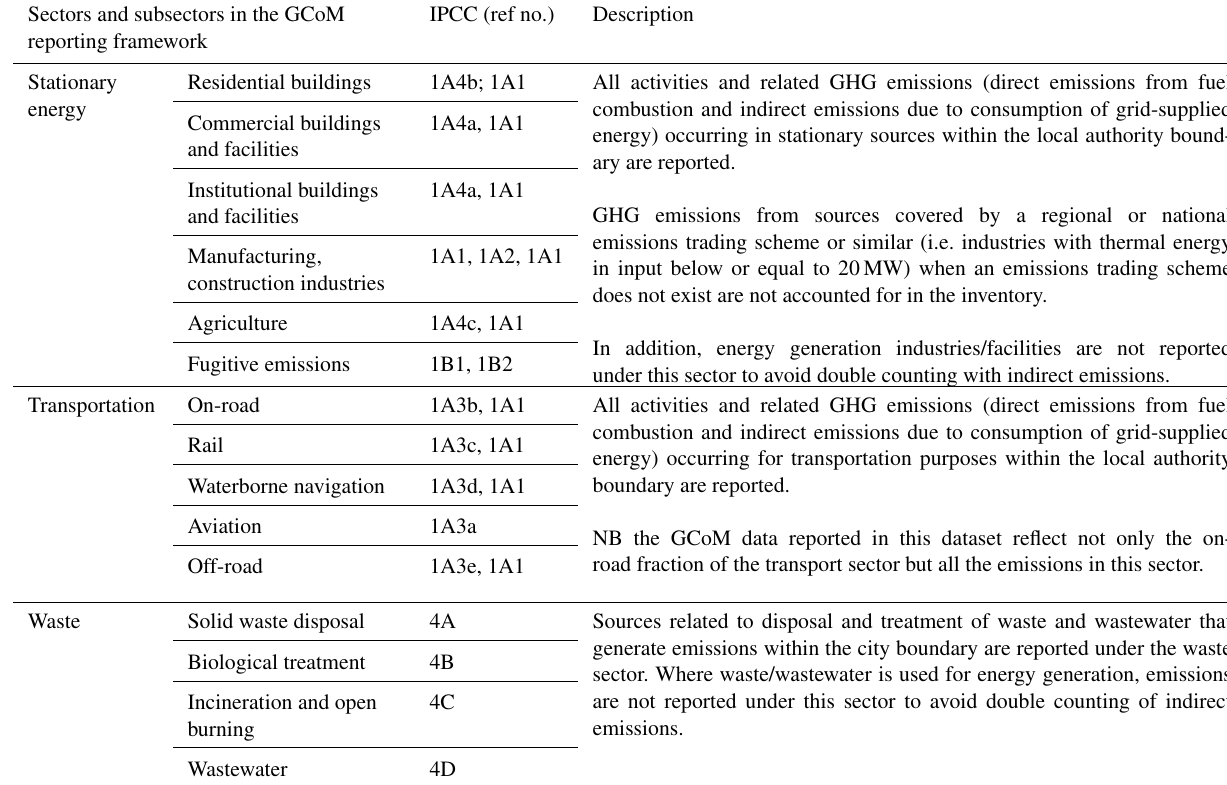
Table 2. Mapping of emission source categories in the GCoM reporting framework based on the IPCC 2006 guidance. Sectors and subsectors in the GCoM